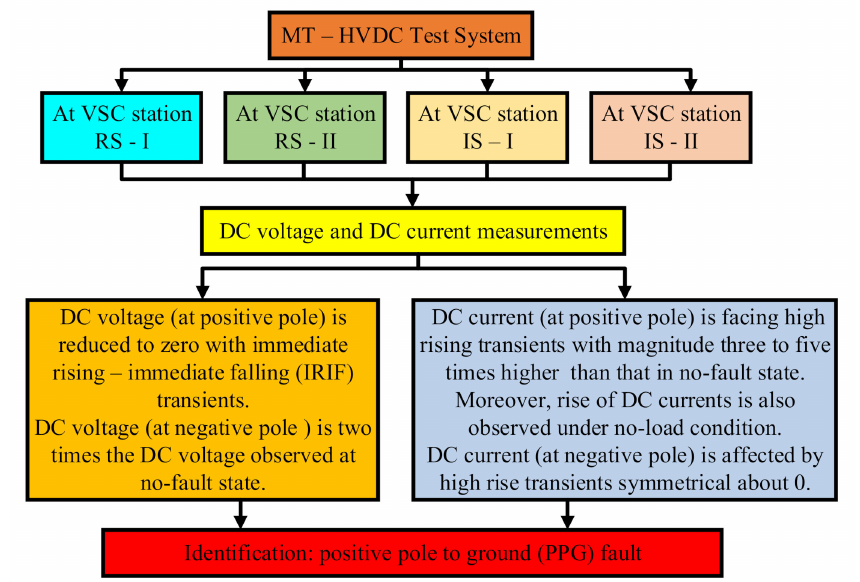
Figure 16. PPG fault identification scheme in the MT-HVDC test